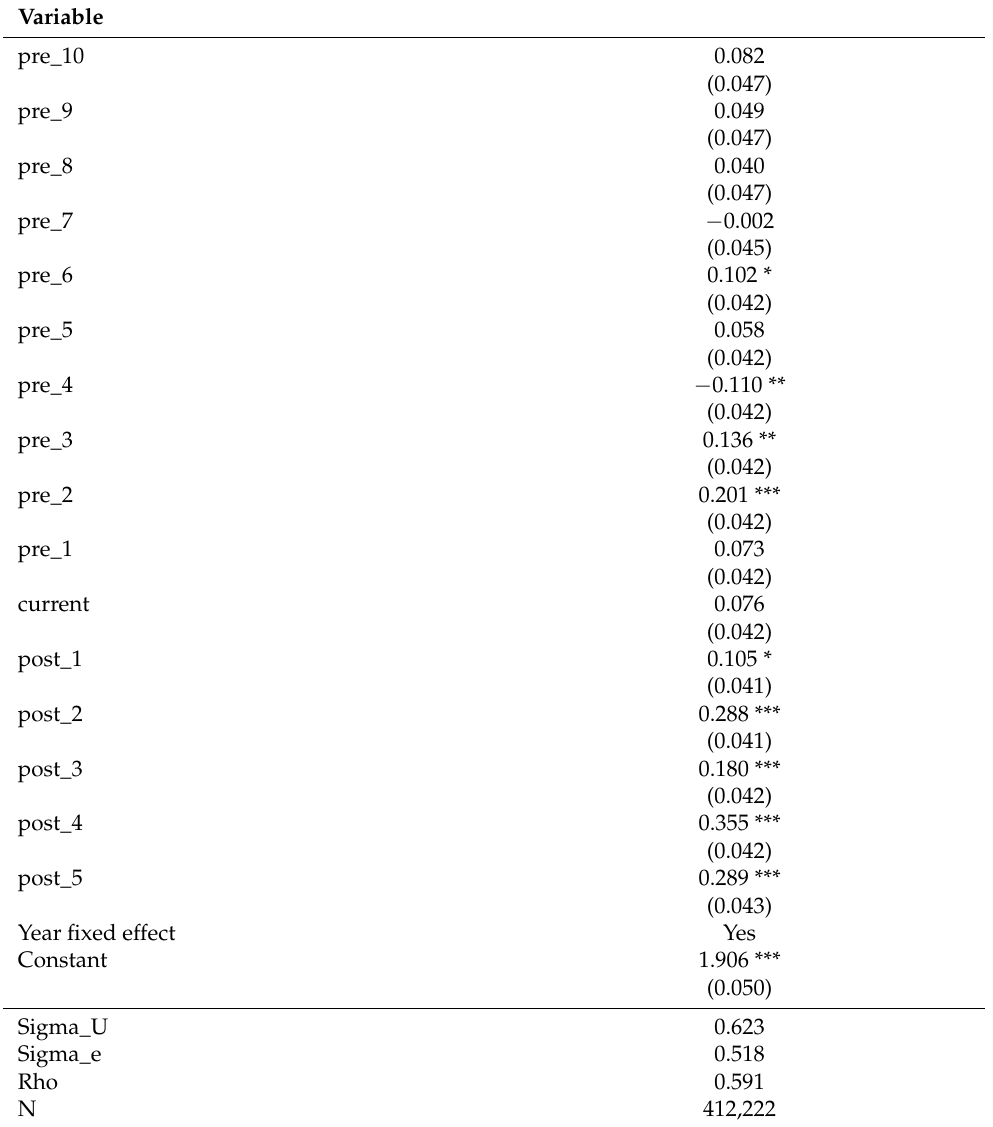
Table 3. DID parallel trend test based on the fixed effect